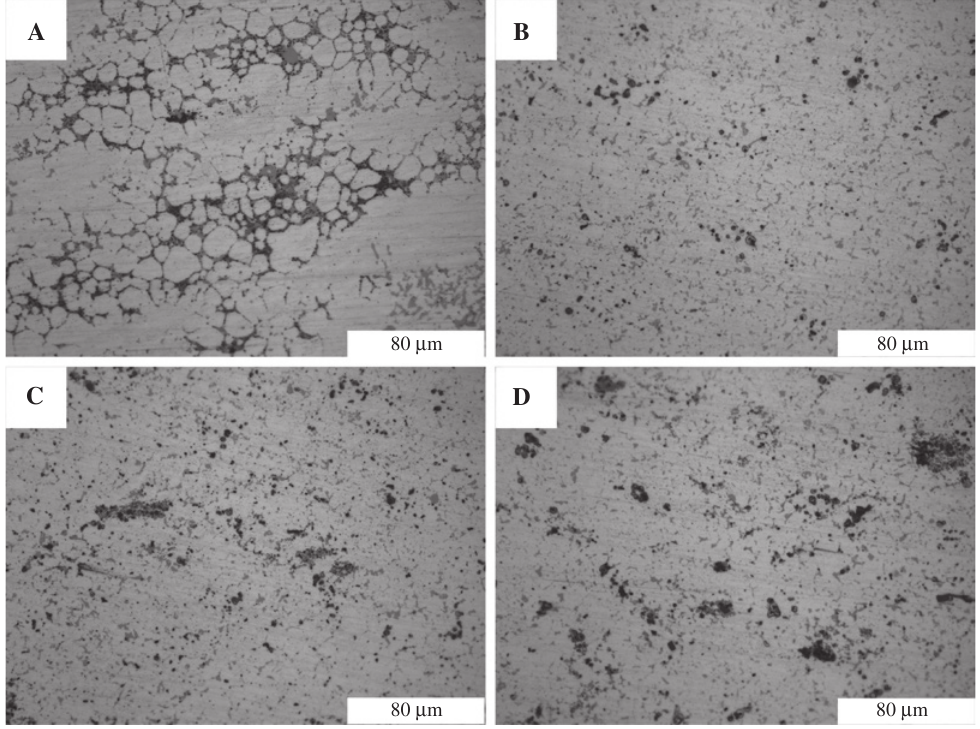
/Al2014 composites after hot p